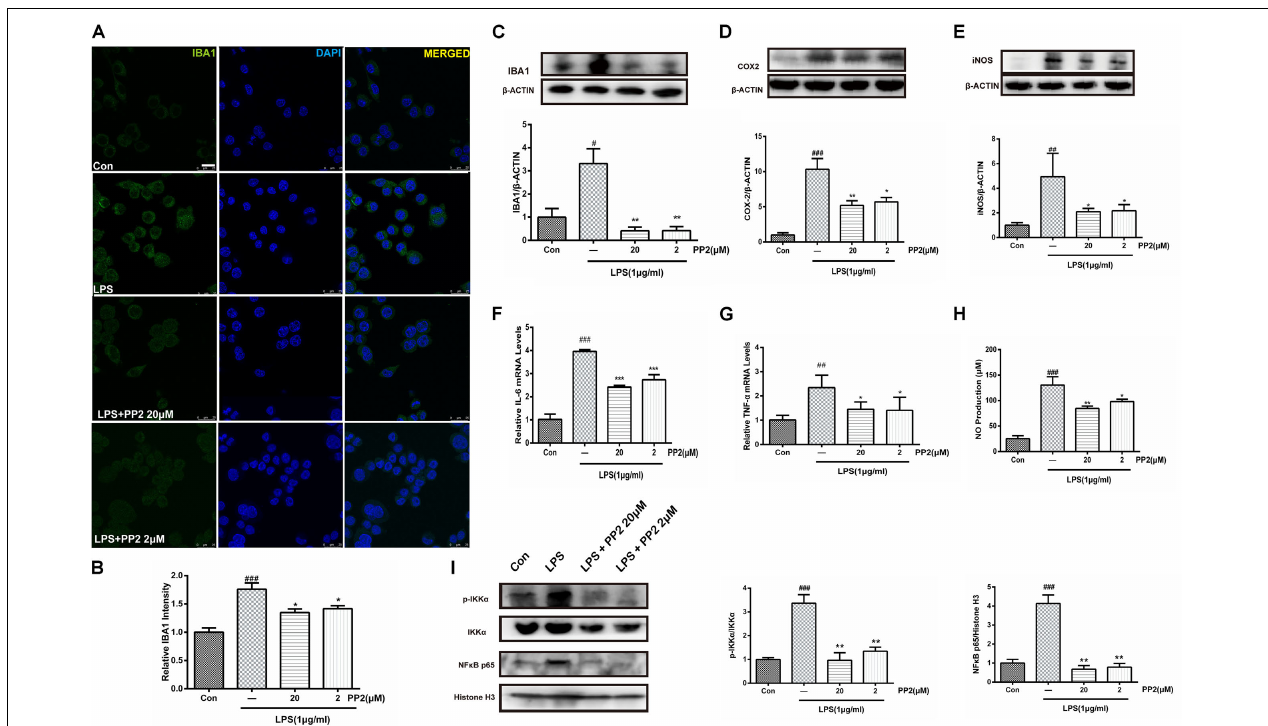
FIGURE 2 | Src inhibition prevented the activation of BV2 microglia and the production of neuroinflammatory molecules subjected to lipopolysaccharide (LPS). (A) Cultured BV2 cells were treated with two concentrations of PP2 (2 and 20 µ M) in the presence of LPS (1 µ g/ml) for 24 h, and then the cells were stained with anti-IBA1 antibody (green) and DAPI stain (scale bar: 8 µ m). (B) Quantification of the IBA1 staining was provided in a histogram. Each bar represents the mean ± SEM. n = 4. ### P < 0.001 vs. control group, * P < 0.05 vs. LPS group. (C) BV2 cells were treated with two concentrations of PP2 (2 and 20 µ M) in the presence of LPS (1 µ g/ml) for 24 h. The protein level of IBA1 was analyzed by western blot with anti-IBA1 antibody. β -Actin was used as an internal loading control. Each bar represents the mean ± SEM. n = 4. # P < 0.05 vs. control group,** P < 0.01 vs. LPS group. (D,E) The protein level of cyclooxygenase-2 (COX2) and iNOS were examined by western blot. Each bar represents the mean ± SEM. n = 4. ### P < 0.001 and ## P < 0.01 vs. control group, ** P < 0.01 and * P < 0.05 vs. LPS group. (F,G) The mRNA levels of IL-6 and TNF- α were analyzed by quantitative reverse transcription (qRT)-PCR. Each bar represents the mean ± SEM. n = 4. ## P < 0.01 and ### P < 0.001 vs. control group, * P < 0.05 and *** P < 0.001 vs. LPS group. (H) The level of NO production was determined using the Griess reaction. Each bar represents the mean ± SEM. n = 5. ### P < 0.001 vs. control group, * P < 0.05 and ** P < 0.01 vs. LPS group. (I) The protein expression level of p-IKK α , IKK α , NF- κ B p65, and histone H3 were measured by western blot. Each bar represents the mean ± SEM. n = 4. ### P < 0.001 vs. control group, ** P < 0.01 vs. LPS